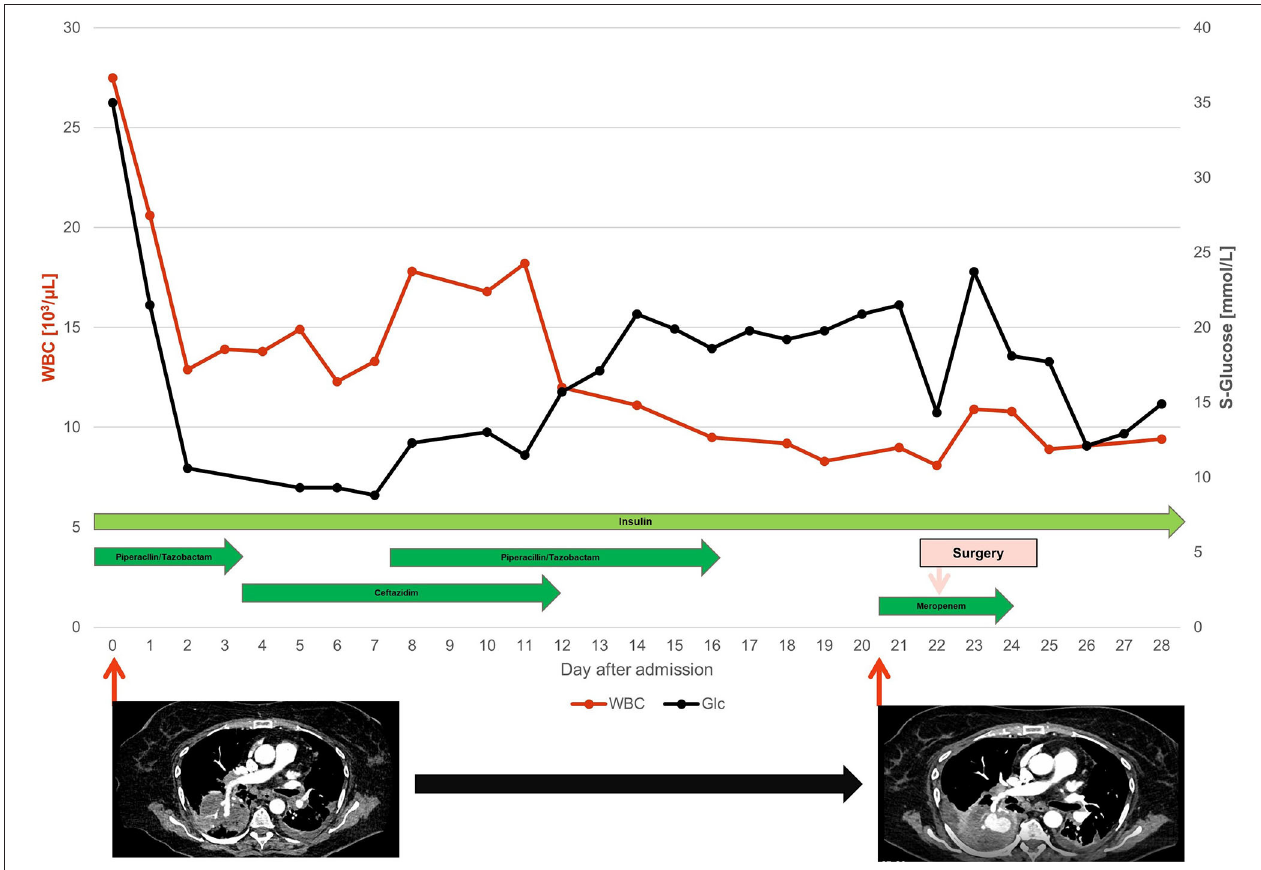
FIGURE 3 | Overview on the clinical course and therapeutic management. With WBC, White blood cell count (red line) and Glc, Serum Glucose (black line) assessed by point of care testing. Duration of the applied antibiotic regimen is indicated by arrow length. Computer tomographic angiography of the thorax was performed twice, revealing progressive intrapulmonary infection of the right pulmonary subsegmental artery with manifestation of an infectious aneurysm (compare Figure 2